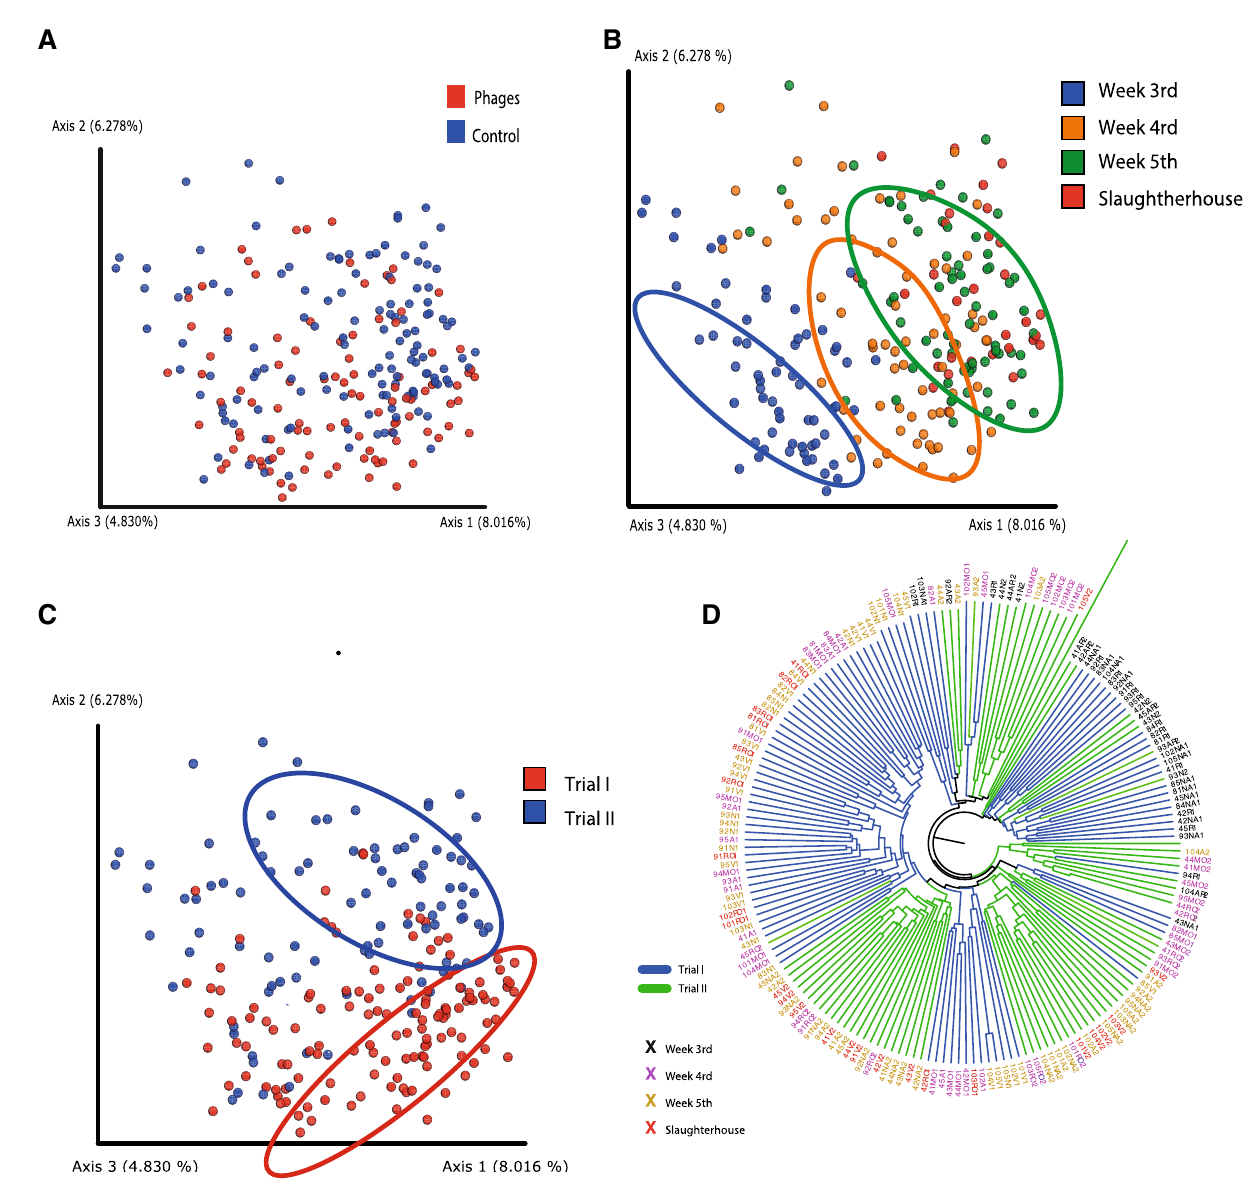
Figure 3. Similarity between the structure of bacterial communities found in cecum of broiler chicken based on Bray Curtis dissimilarity metric. ( A–C ) Principal Coordinate Analysis (PCoA) where samples are colored by treatment ( A ) age of the animals (in weeks) ( B ) and by trial ( C ). Ellipses were manually overlaid to encompass the majority of the sample points of a given feature. ( D ) UPGMA clustering colored by cycle and sampling week. This figure was made using the Qiime2 package version 2018.1156 and its plugins (https:// qiime2.